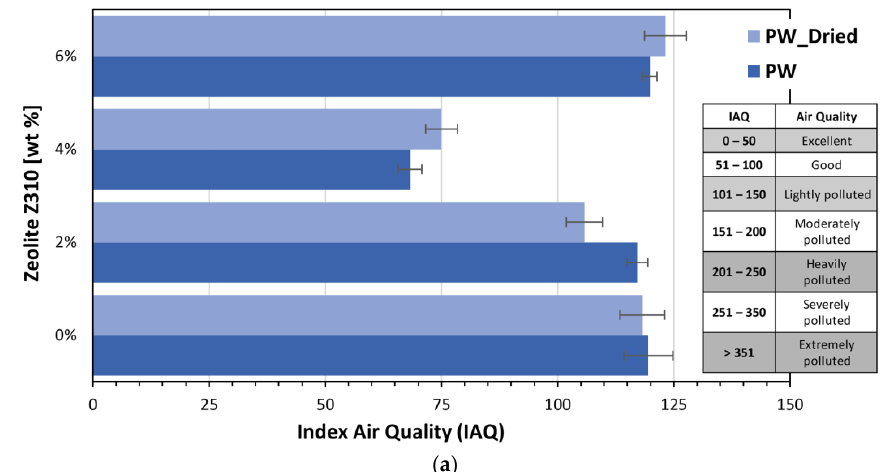
Figure 11. SEM images of Fil-S+4% 13X and Fil-S+6% 13X. Red circles highlight zeolite’s particles.